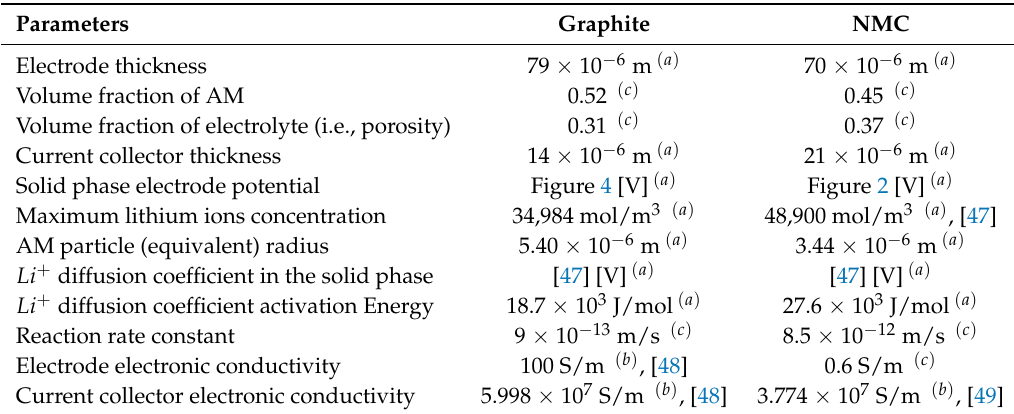
Table A1 lists the electrochemical parameters values associated to the uncycled porous electrodes. Table A1. Electrochemical parameters values: uncycled porous